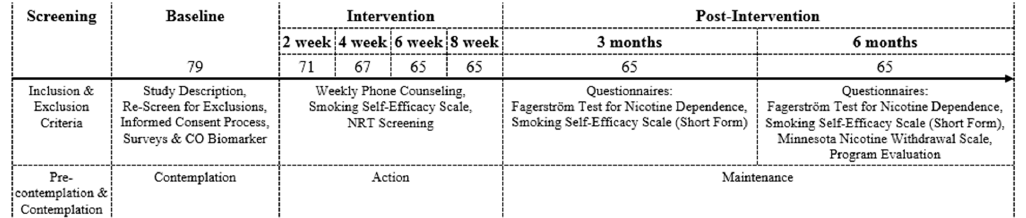
Figure 2. The number of participants across the phases of the study.